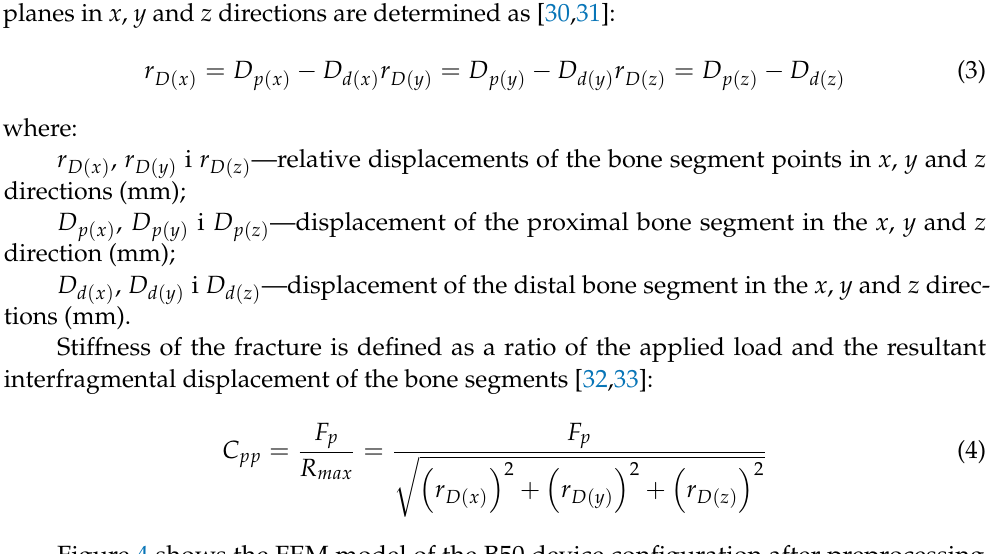
Figure 4. FEM model (B50) in structural analysis; ( a ) preprocessing, ( b ) postprocessing. Relative displacements for the pair of points on proximal and distal bone segment planes in x , y and z directions are determined as